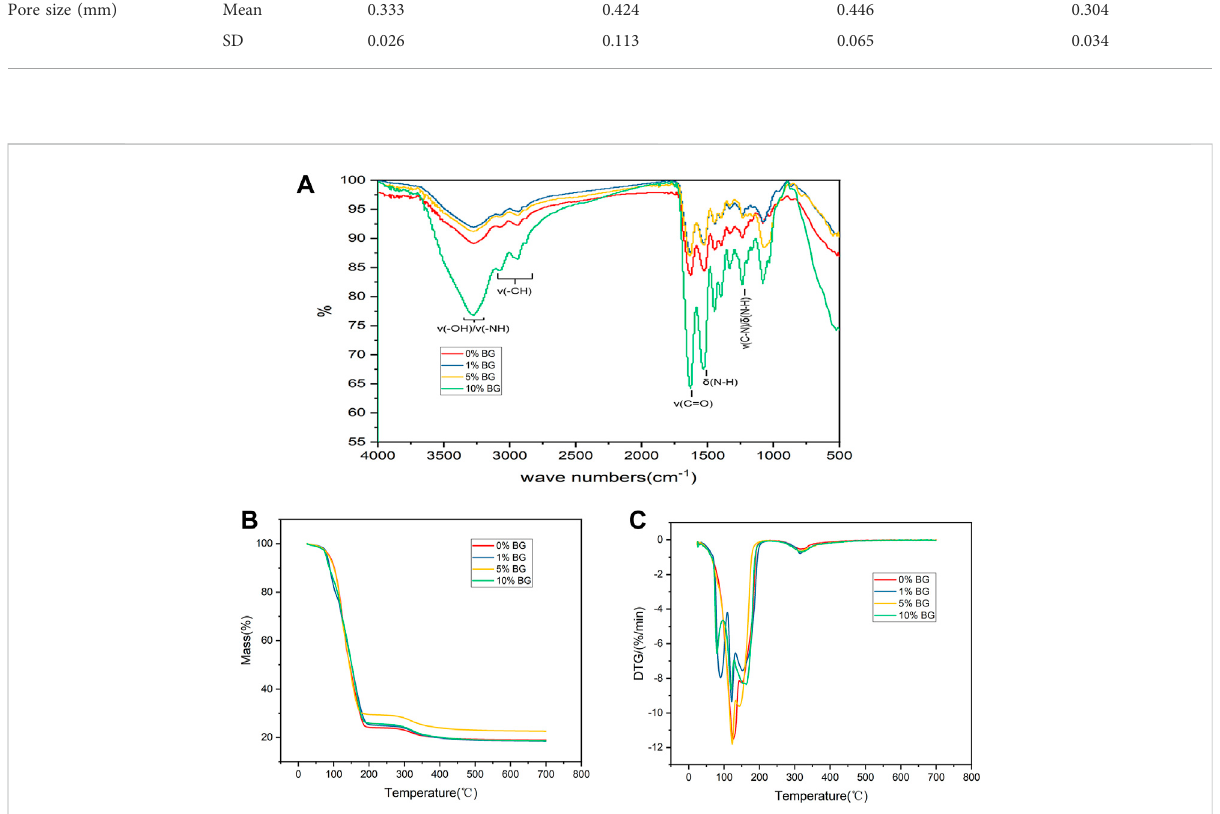
FIGURE 4 Characterization and thermal properties analysis of 3D-printed mesoporous BG/GelMA macropore scaffolds (A) FTIR spectra of BG/GelMA scaffolds with different mass ratios of BG NPs. The symbol ‘ ν ’ means stretching vibration while δ means bending vibration; (B) Thermogravimetric analysis (TGA); (C) Derived thermogravimetric (DTG) of